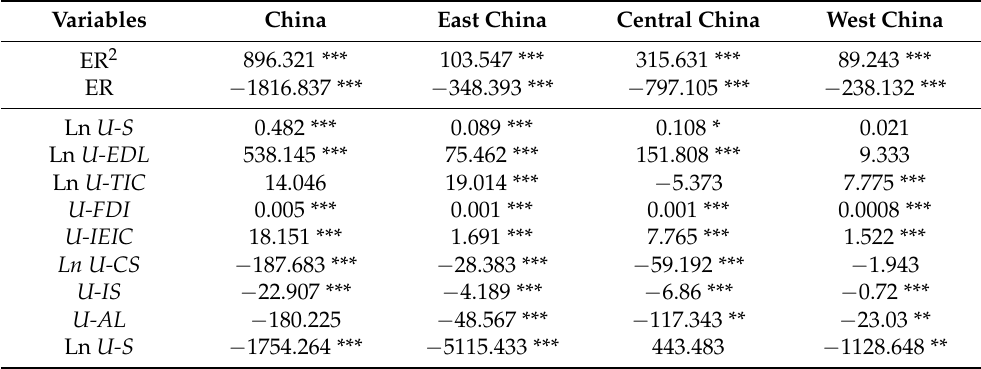
Table 9. Regression results from different regions of